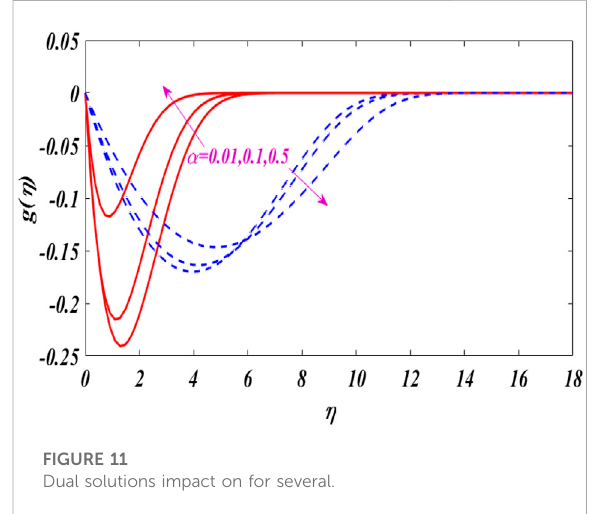
FIGURE 13 Dual solutions impact on for several K .